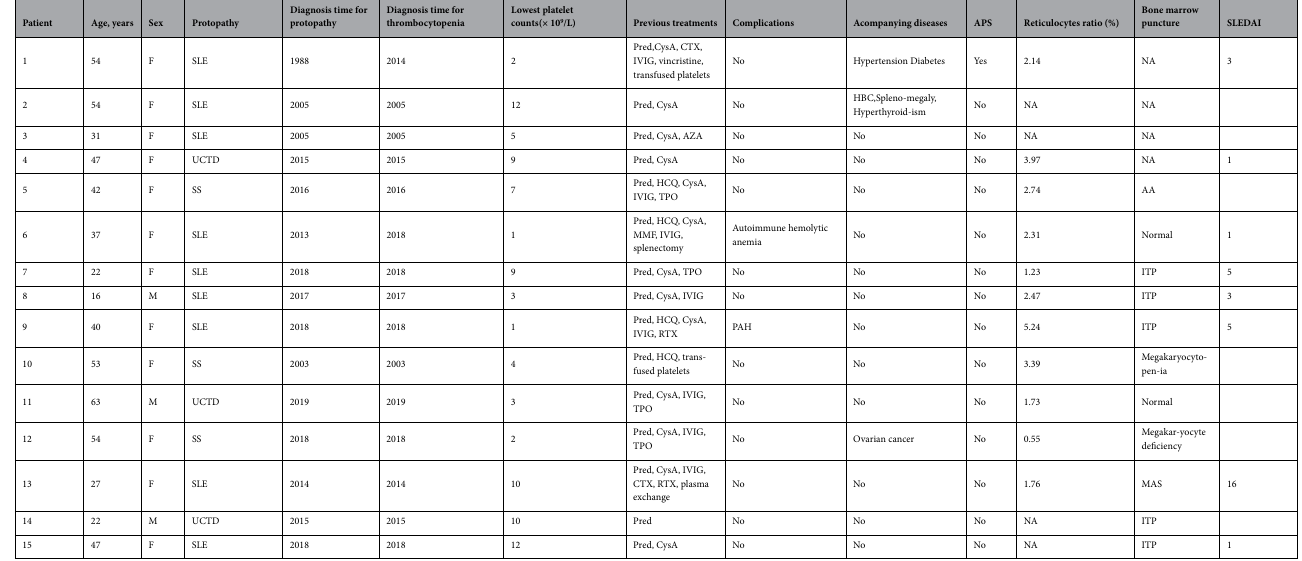
Table 1. Patient characteristics. F female, M male, SLE systemic lupus erythematosus, SS sjogren’s syndrome, UCTD undifferentiated connective tissue disease, Pred prednisolone, CysA cyclosporin A, AZA